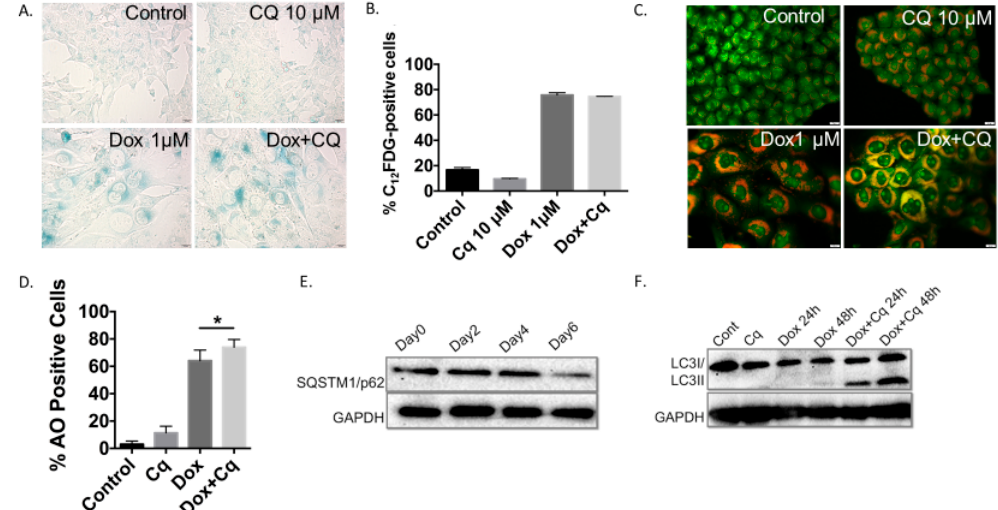
Figure 3. The induction of senescence and autophagy in 4T1 cells in response to doxorubicin ( A ) Induction of senescence determined by elevated senescence-associated β -galactosidase staining in 4T1 cells treated with 1 µM doxorubicin (Dox) for 2 hours (20x objective). ( B ) Quantification of senescence by FACS analysis based on C 12 FDG staining of 4T1 cells. ( C ) Fluorescence microscopy images showing an increase in acridine orange staining in cells treated with Dox (1 µM). 4T1 cells were pre-treated with CQ (10 µM) for 3 hours followed by 2 hour exposure to Dox with or without CQ (20x objective). ( D ) Quantification of autophagic cells by FACS analysis in response to Dox treatment showing accumulation of acridine orange (AO) positive cells that is further enhanced by inhibition of acidic degradation by CQ. ( E ) Induction of autophagy confirmed by Western Blot showing degradation of p62/SQSTM1 protein following a 2 h exposure to Dox (1 µM). ( F ) Blockade of autophagic flux by chloroquine resulting in accumulation of LC3BII protein. * p < 0.05 compared to untreated controls.